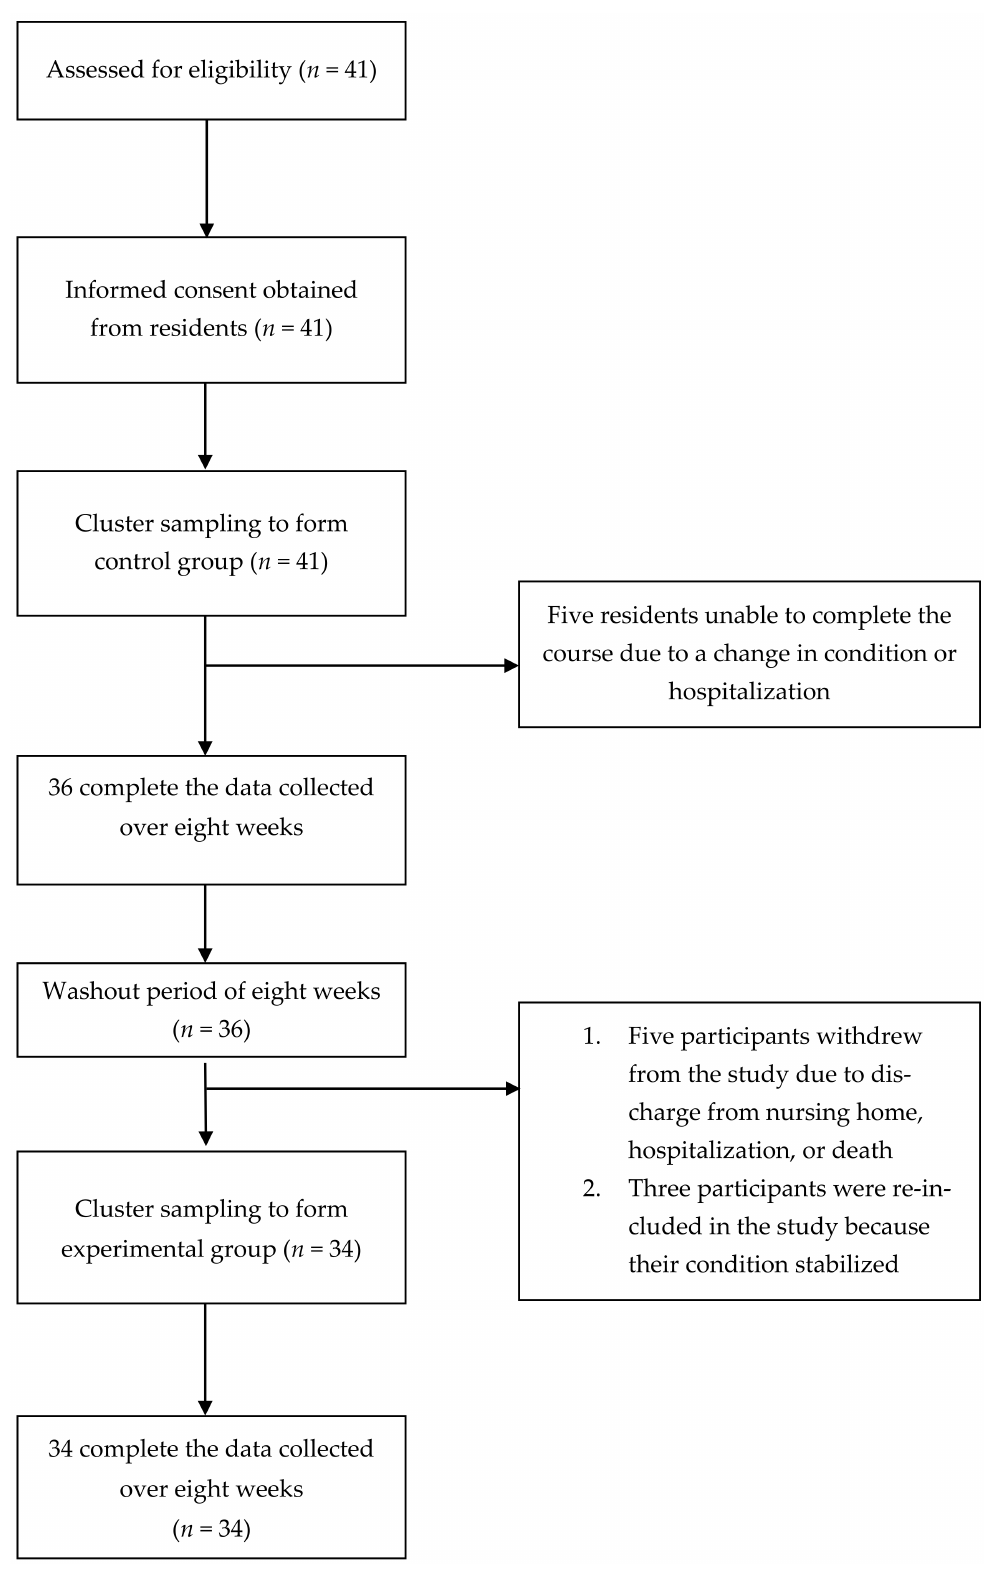
Figure 2. Flow diagram of study participant recruitment. The mean age of the 41 participants was 80.14 years. The majority of the partici- pants were female (63.4%), ate a minced diet (61.0%), and ate predominantly indepen- dently (92.7%). The mean reported BMI was 21.42 ± 3.22 kg/m 2 , calf circumference